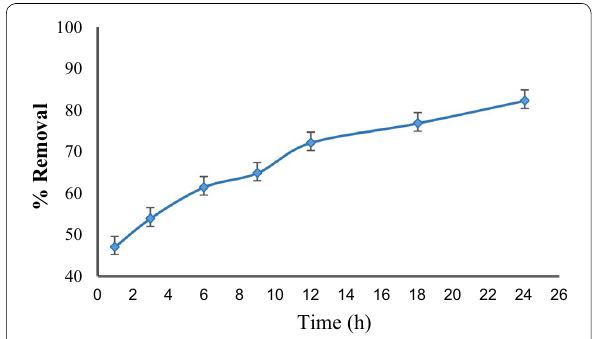
Fig. 2 Effect of contact time on the bisacodyl adsorption process, the conditions were pH of 7, initial concentration of 5 mg/l and adsorbate mass of 0.5 mg in 100 ml. The experiments were performed in triplicate, and the mean and error bar are presented on